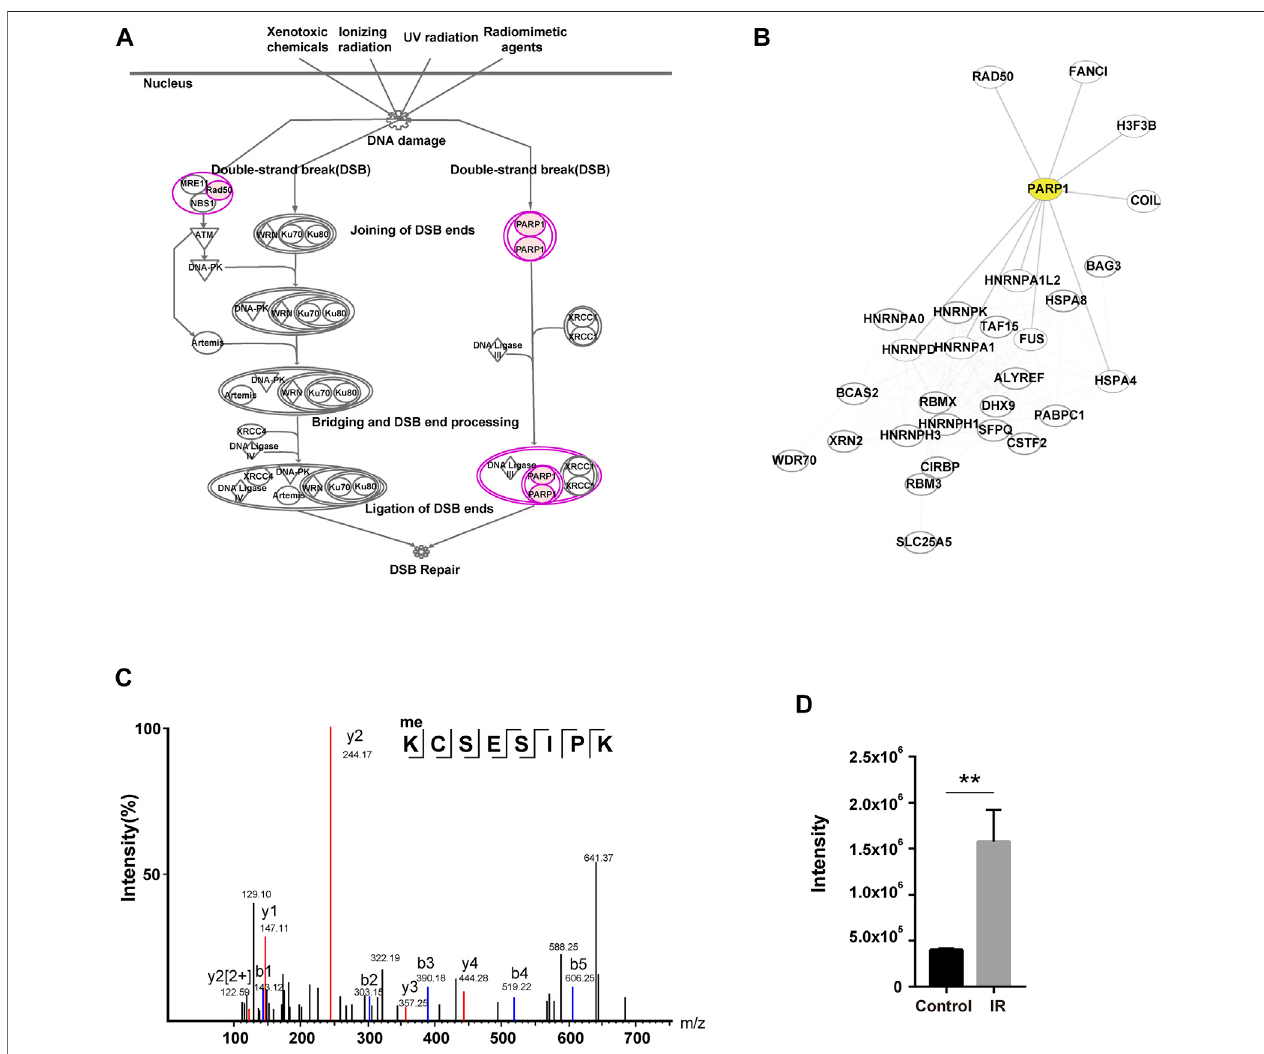
FIGURE 3 | Characterization of a novel methylation of PARP1 upregulated in response to IR. (A) DNA damage pathway (DNA double-strand break repair by nonhomologous end joining) in IPA analysis. The identi fi ed PARP1 and RAD50 are shown in pink (log2-fold change > 1). (B) PPI network of the DDR proteins in two DNA damage-related pathways identi fi ed with IPA. The proteins involved in pathways of DNA double-strand break repair by nonhomologous end joining and telomere extension by telomerase. PARP1 is highlighted in yellow. (C) The MS/MS fragmentation pattern of the methylated K23-containing peptide of PARP1. the B and Y ions for a given peptide represent the two halves formed by splitting the original peptide between various amino acids. For a given peptide sequence, the B ions are the product when the charge is retained on the N-Terminus (i.e. at the beginning ofthe sequence) and the Y ions the product when the charge is retained at the C-Terminus (i.e. at the end of the sequence). The identi fi ed B ions are shown in blue and Y ions are shown in red. (D) Quanti fi cation of the methylated K23-containing peptide of PARP1 in MS/MS with and without IR treatment. ** p < 0.01.